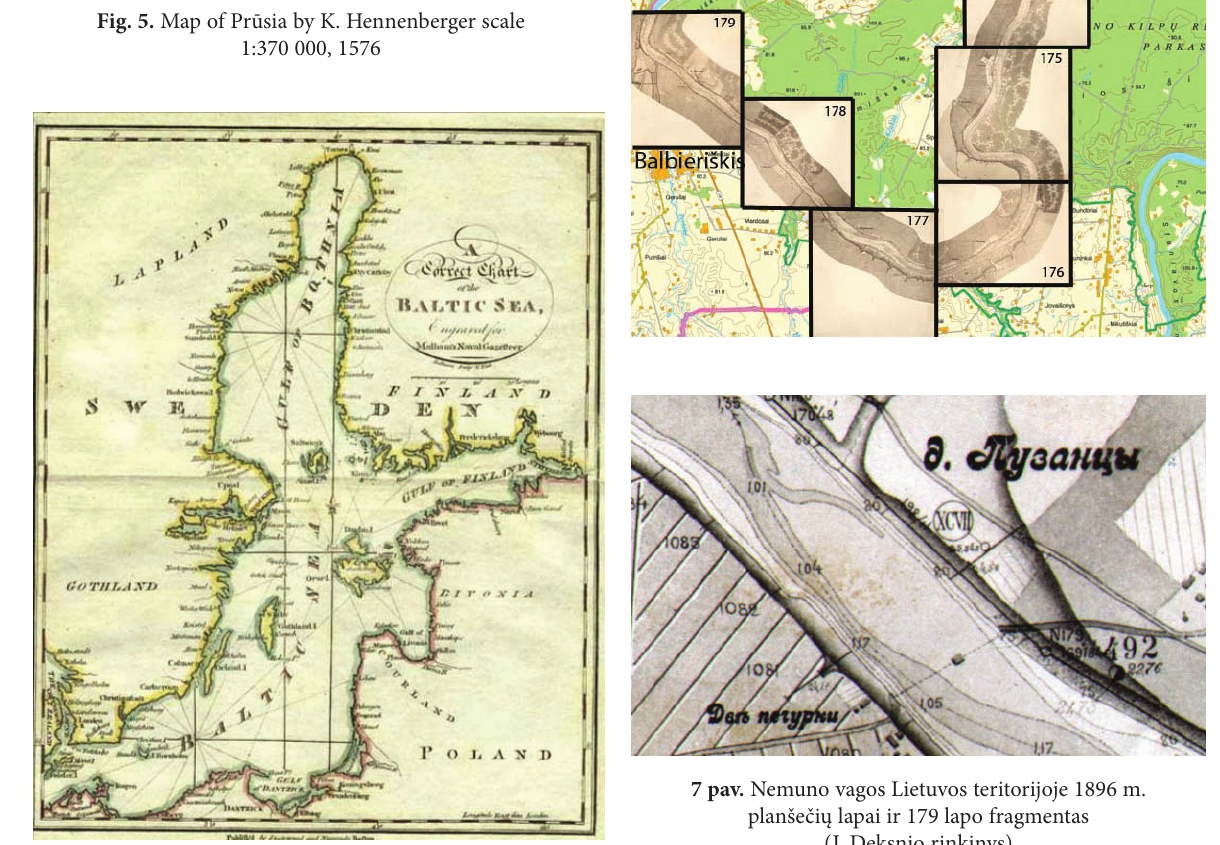
Fig. 5. Map of Prūsia by K. Hennenberger scale